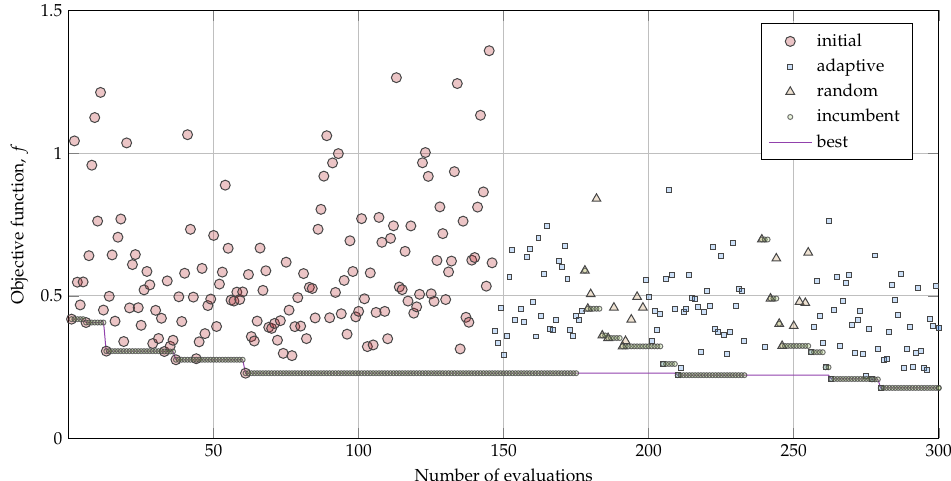
Figure 8. Plot of objective function versus number of optimization evaluations using surrogateopt for quartz with 4 polyhedral